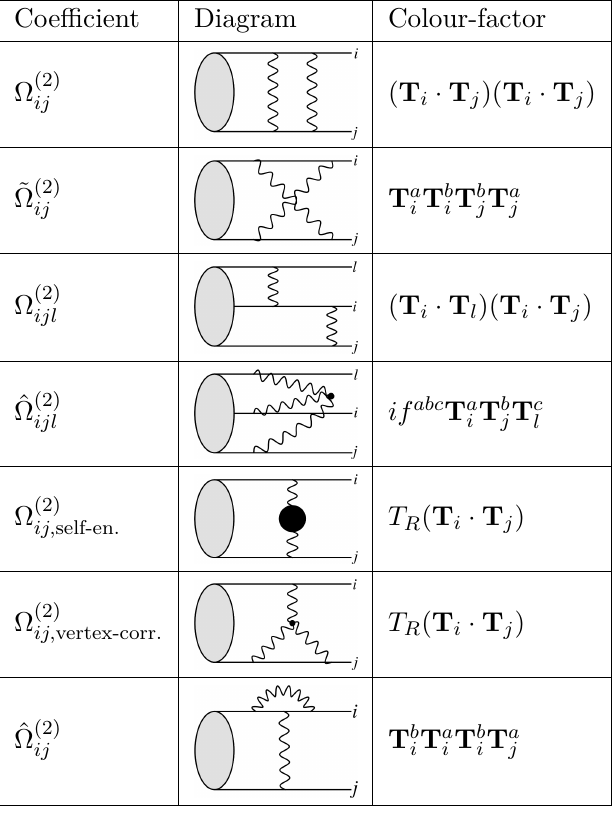
Table 1 . Two-loop diagrams contributing to the anomalous dimension, and the colour structures we extract in order to define the coefficients of the basis independent notation. See text for more